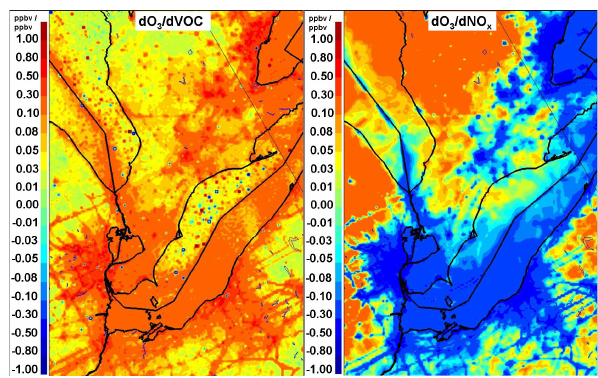
Fig. 21. Change in ozone after a two-minute timestep relative to change in (a) total VOC, and (b) NO x